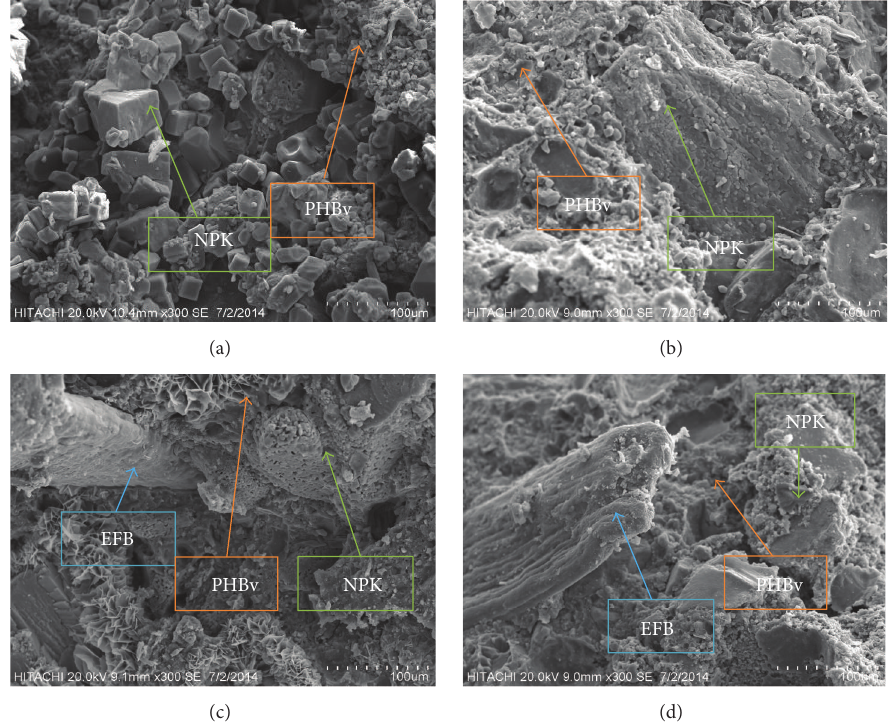
Figure 4: SEM of bioplastic fertilizer (BpF) composites. (a) PHBv/NPKC1, (b) PHBv/NPKC2, (c) PHBv/EFB/NPKC1, and (d) PHBv/EFB/ NPKC2. Note: PHBv (poly(hydroxybutyrate-co-valerate)), NPKC1 (uncoated) and NPKC2 (coated), and EFB (empty fruit